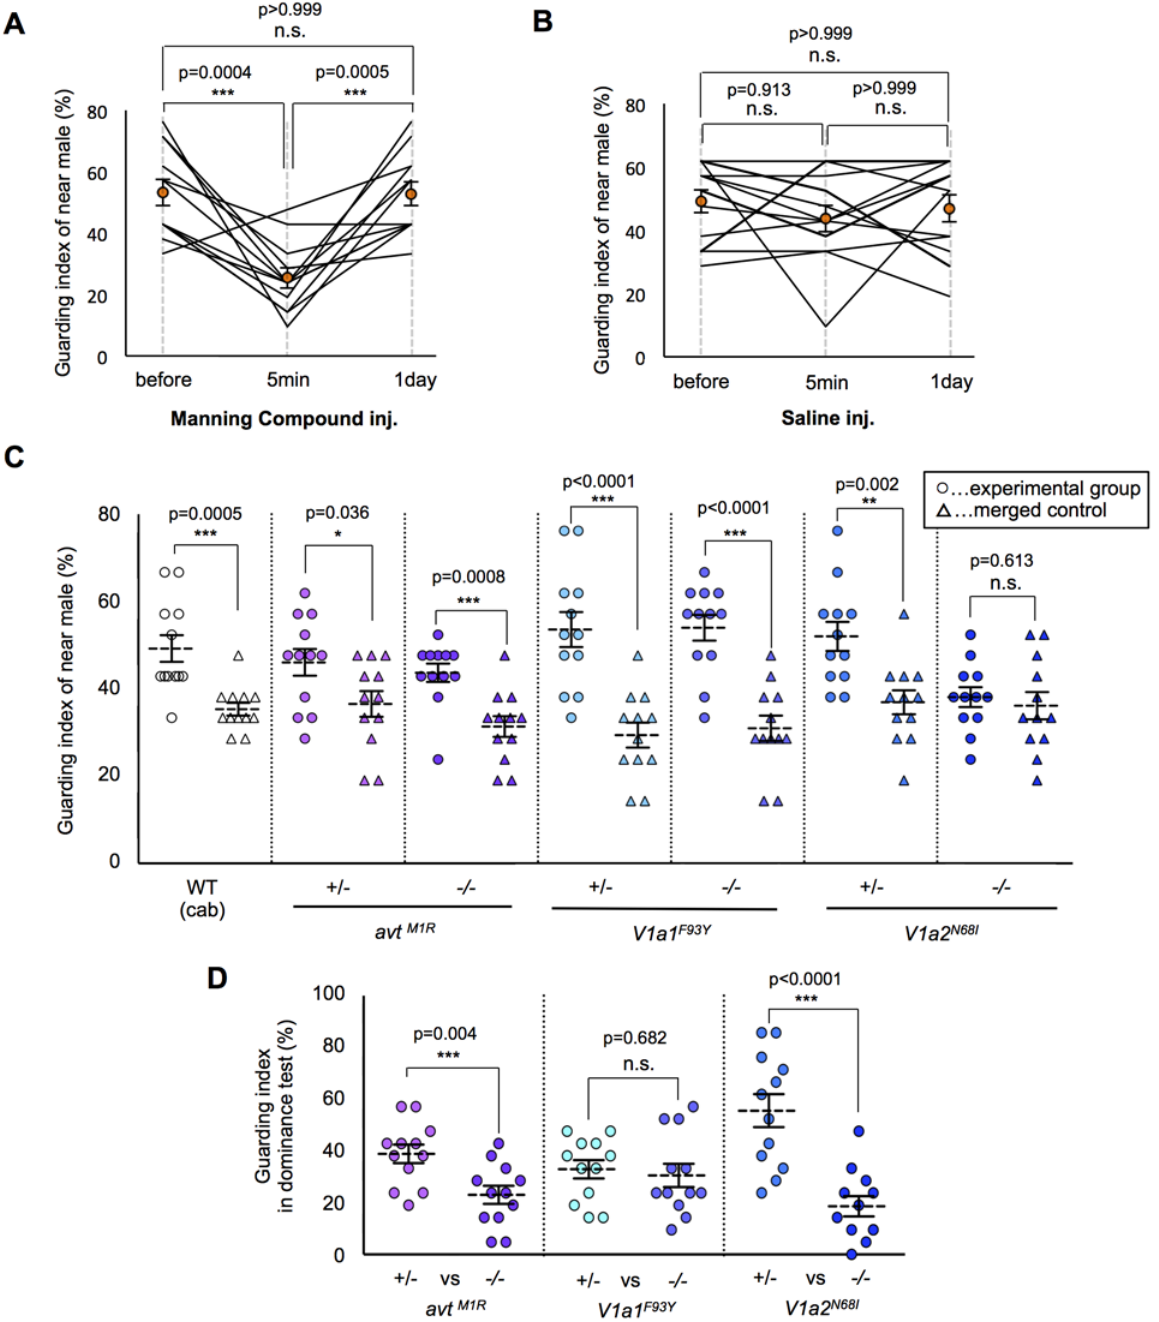
Fig 3. Effect of the AVT system on mate-guarding behavior. (A) Manning compound injection decreased the guarding index. Mean ± SEM. Each n = 12, one-way repeated measures ANOVA: Bonferroni correction, *** P < 0.001. (B) Saline injection didn ’ t change the guarding index. Mean ± SEM. Each n = 12, one-way repeated measures ANOVA. (C) Effect of the AVT system on emergence of mate-guarding behavior (guarding test). avt ( avt M1R/M1R ) and V1a1 ( V1a1 F93Y/F93Y ) mutants exhibited mate-guarding behavior, whereas V1a2 ( V1a2 N68I/N68I ) mutants did not. Mean ± SEM. Each n = 12, Student ’ s t-test: * P < 0.05, ** P < 0.01, *** P < 0.001. (D) Effect of the AVT system on dominance of mate-guarding behavior (dominance test). avt homozygote mutants ( avt M1R /M1R ) and V1a2 homozygote mutants ( V1a2 N68I/N68I ) tended to be subordinate males in the dominance test. Mean ± SEM. Each n = 12, Student ’ s t- test: *** P <